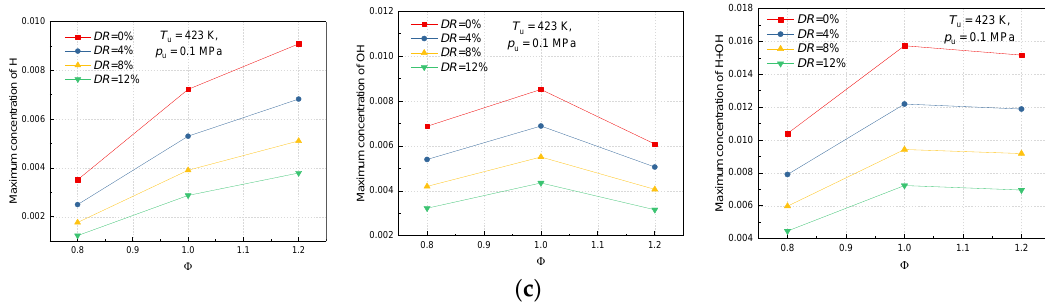
Figure 11. Maximum concentration of H, OH and H + OH. ( a ) Under di ff erent initial pressures; ( b ) Under di ff erent initial temperatures; ( c ) Under di ff erent dilution rates.